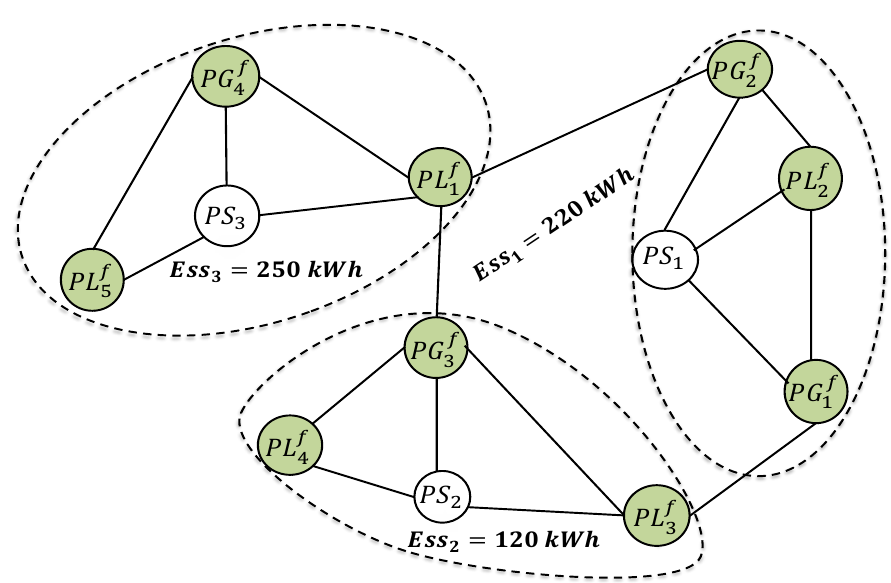
Figure 24. One possible localization for installing storage devices. In the third configuration shown in Figure 25, the location of three power storage devices is altered, and the minimum capacity level of all power storage devices is obtained as Ess 1 = 190 kWh, Ess 2 = 350 kWh, and Ess 3 = 80 kWh. The total capacity is computed as Ess = 620 kWh.